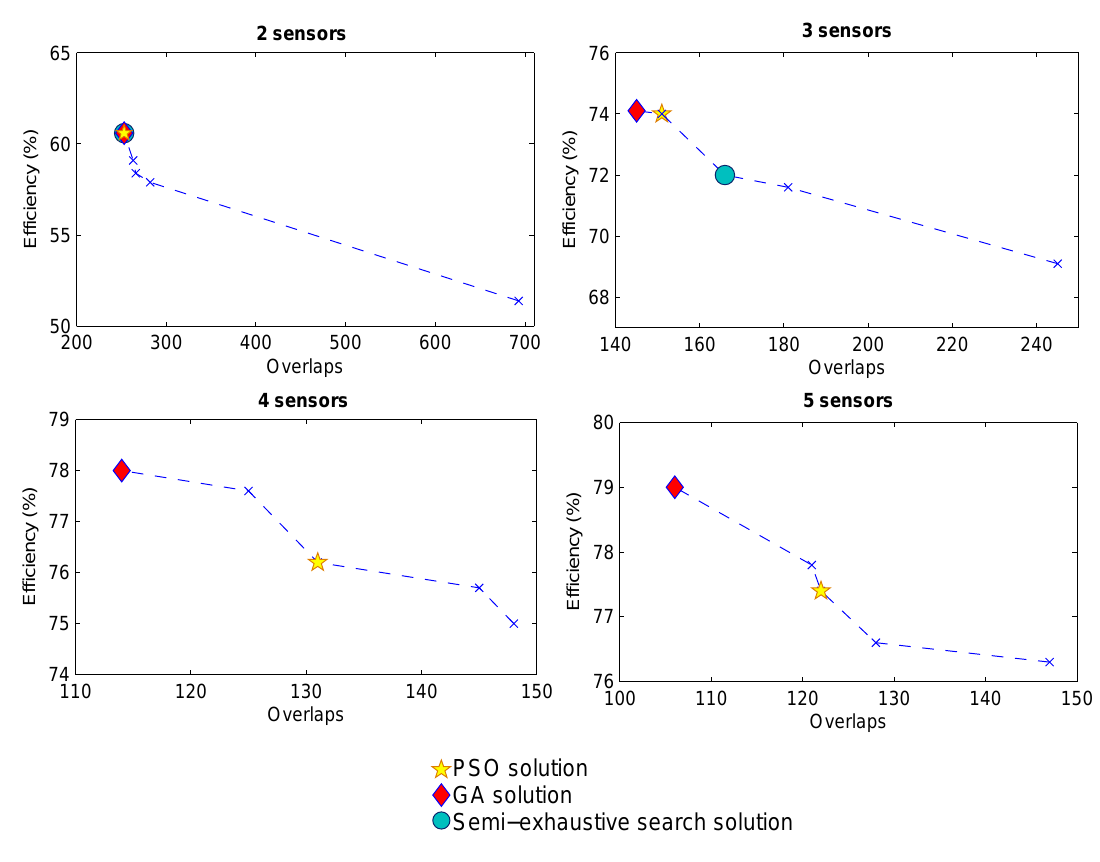
Figure 3. Efficiency in leak location according to the number of overlaps in the configuration for the Limassol